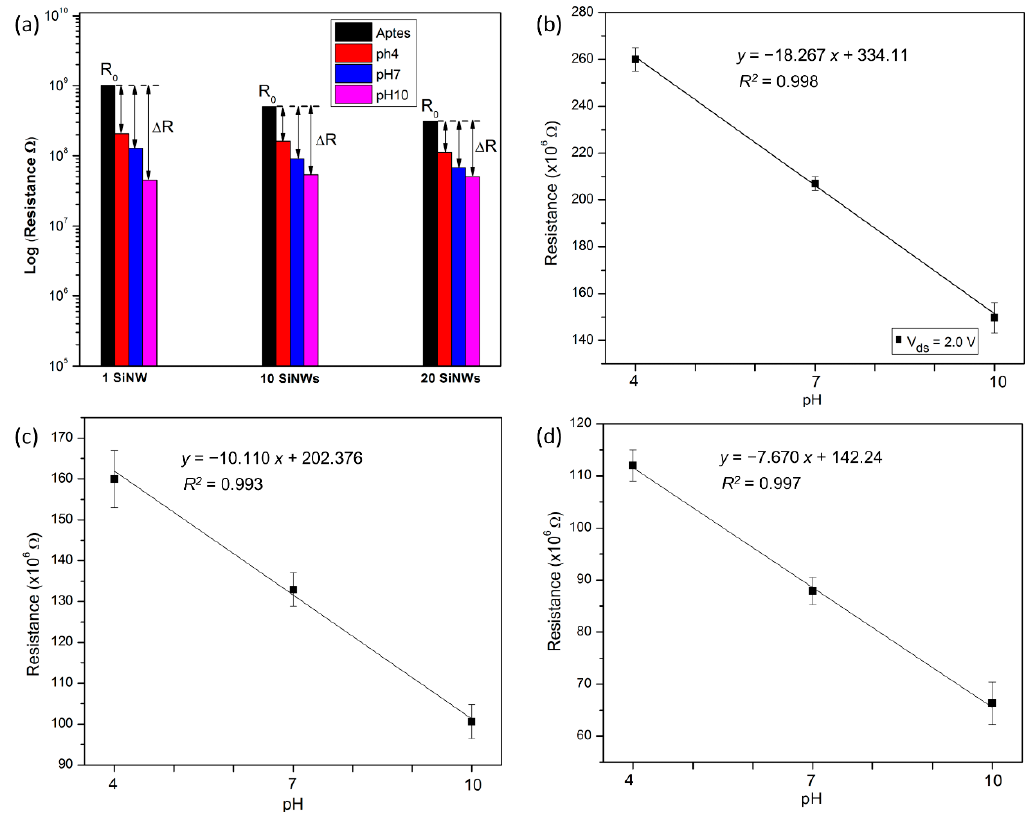
Figure 6. ( a ) The average resistance measurement of sensor devices with different numbers of SiNW (i.e., single NW, 10 NWs, and 20 NWs) for pH sensing. Change of electrical resistance by different pH levels for ( b ) single SiNW device, ( c ) 10 SiNWs device, and ( d ) 20 SiNWs